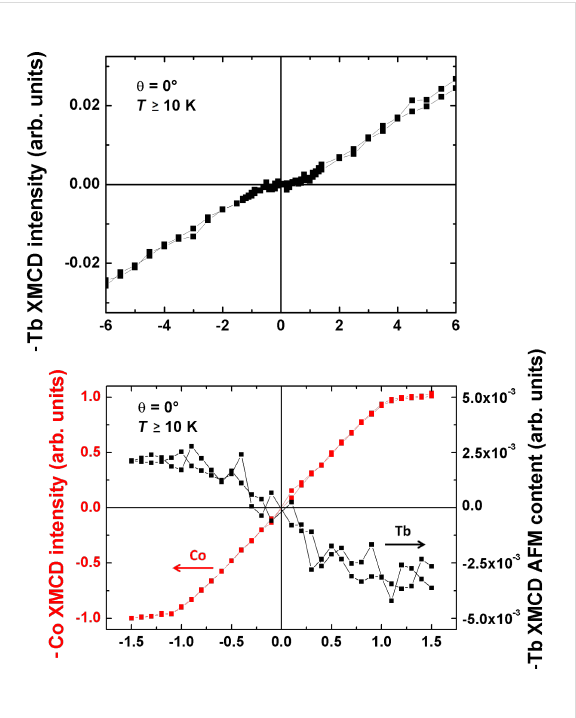
Figure 4: Magnetization curves for the sample TbPc 2 /Ni/Cu(100). The top figure shows the magnetization curve at the maximum of the M 5 edge of Tb (1235.4 eV) from − 6 T to 6 T. In the bottom figure one can see the magnetization curve at the maximum of the L 3 edge of the Co XMCD signal (778 eV) (red line) and the Tb M 5 curve after subtraction of a linear signal (black curve). The measurements were performed at perpendicular X-ray incidence at T ≥ 10